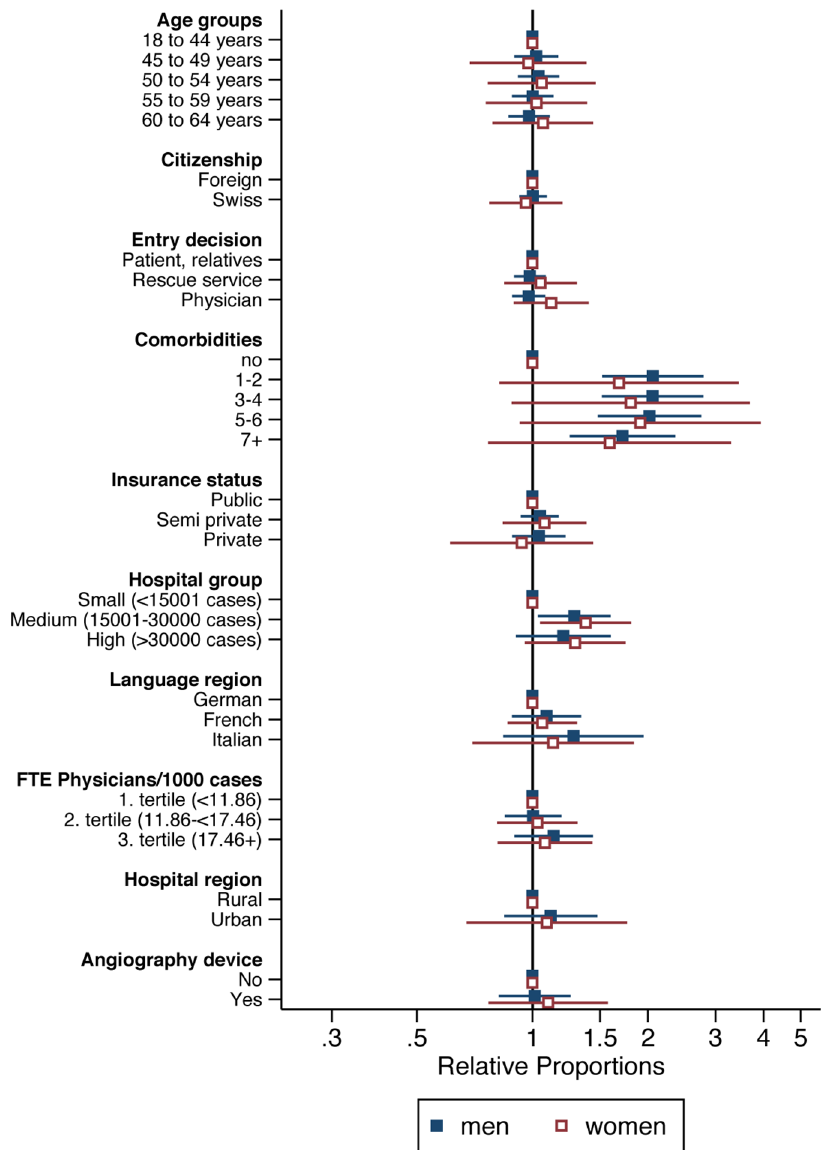
Fig 3. Results of multilevel Poisson regression for revascularization for male and female patients younger than 65 years.